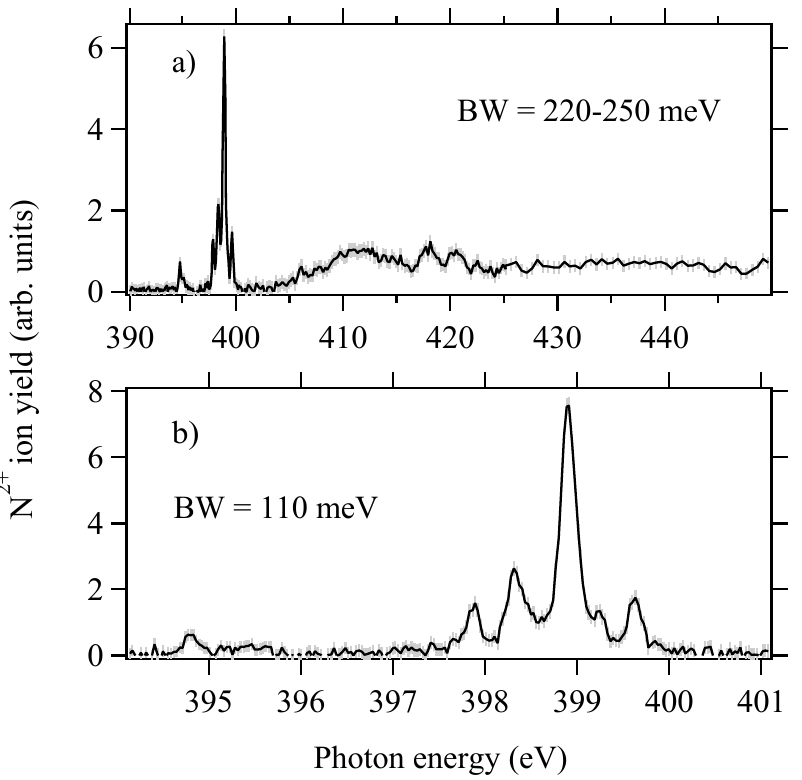
Figure 1. Experimental N 2 + ion yield spectra of NH + : ( a ) Recorded on the full photon energy range 390–450 eV with a photon bandwidth (BW) varying between 220 and 250 meV. ( b ) High-resolution spectrum obtained in the region 394–401 eV with a bandwidth of 110 meV.